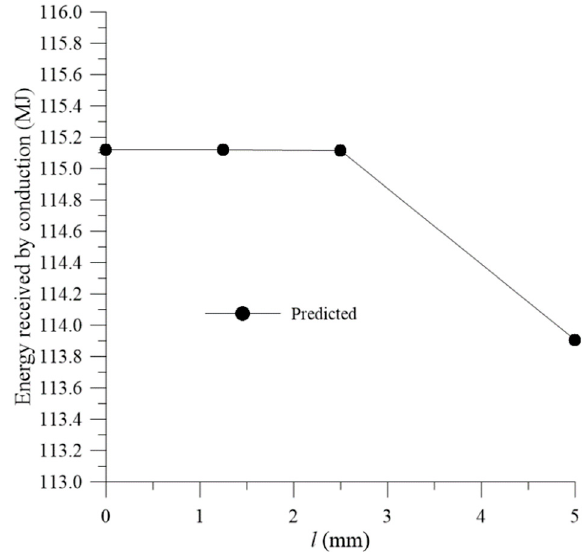
Figure 18. Conduction energy gain by the thermal insulation during the heating process as a function of the mesh parameter ( l ).